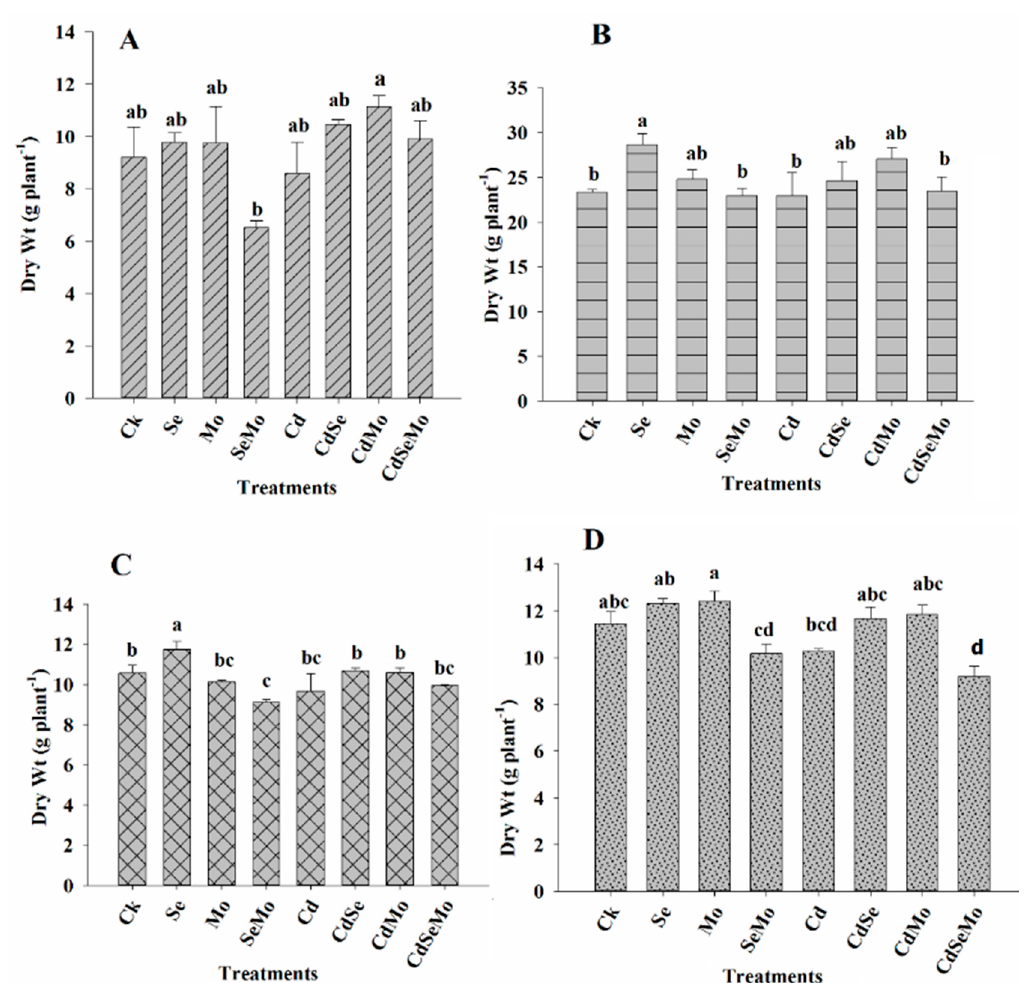
Figure 1. Dry biomasses of B. napus grown under different experimental conditions. Dry weight of root ( A ), stem ( B ), glume ( C ), and seed ( D ) of oilseed rape treated with foliar spray of (1 mg/L) Se and/or (0.3 mg/L) Mo in absence or presence of Cd stress (5 mg/kg). All data show the means ± SD of four replicates. Different letters within a column indicate significant ( p < 0.05) differences between treatments.